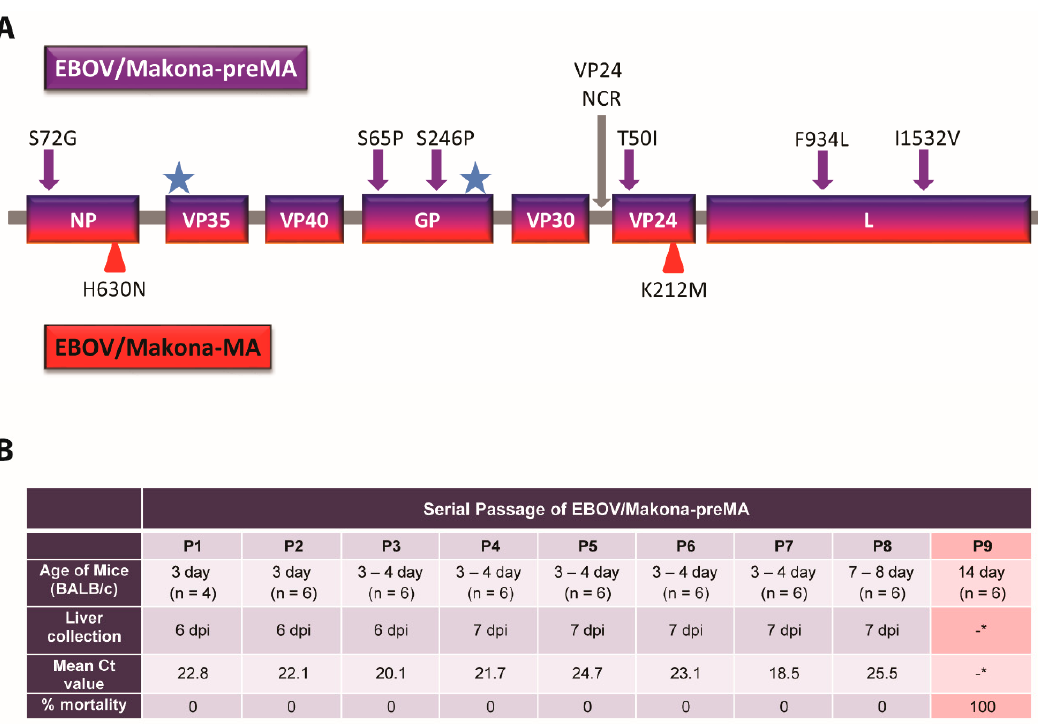
Figure 1. Generation of Ebolavirus (EBOV) / Makona-mouse-adapted (MA) by serial passage in suckling BALB / c mice. ( A ) The EBOV / Makona-preMA genome consisted of six mutations associated with EBOV / Mayinga-MA that were inserted into the coding regions of NP, GP, VP24, and L genes (purple arrows). An additional EBOV / Mayinga-MA mutation in the non-coding region (NCR) of VP24 was inserted (gray arrow). Two EBOV / Mayinga-MA mutations already existing in the EBOV / Makona genome are denoted (blue star). Two additional mutations in NP and VP24 were identified in EBOV / Makona-MA after serial passaging (red triangles). ( B ) Serial passage of EBOV / Makona-preMA in progressively older suckling BALB / c mice resulted in the production of EBOV / Makona-MA. For each passage, livers were collected, pooled, and used to infect a new set of naive mice. Corresponding viral loads were measured by RT-qPCR for EBOV L (mean Ct values shown), *no livers were collected from P9 mice as all mice succumbed to infection.